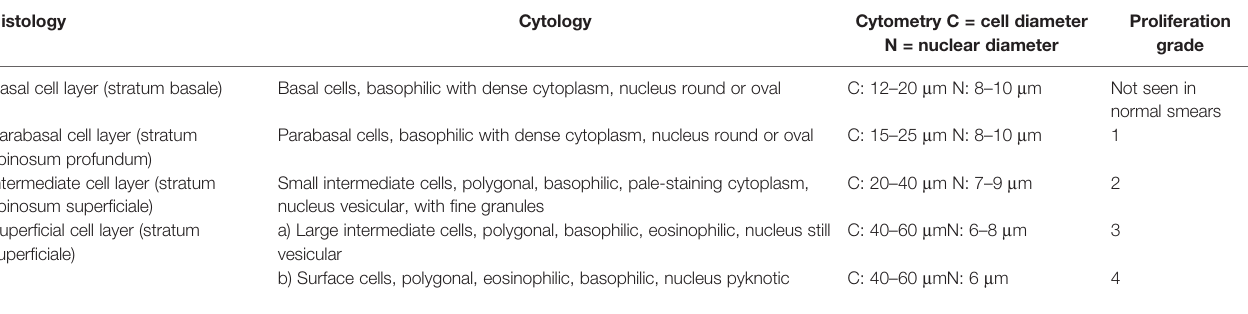
TABLE 3 | Histology and cytology of normal squamous epithelium from the vagina and the ectocervix.